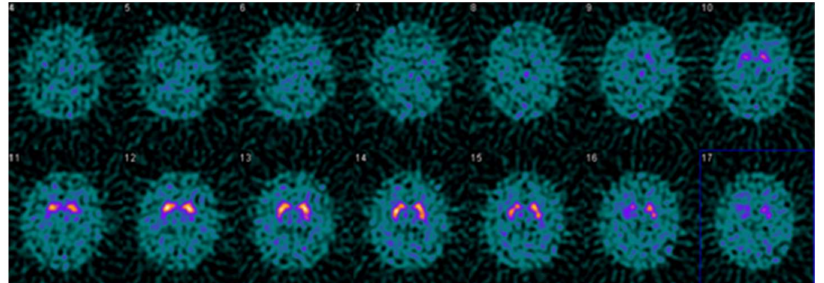
Figure 5. Example DaTQUANT results in a non-PS patient demonstrating visually normal appearing striatum bilaterally. However, the right posterior putamen z-score is − 2.15, meeting the threshold for a diagnosis of PS. This is an example of false-positive quantification, reinforcing the idea that quantification is a useful tool for interpretation, but should not replace visual evaluation. Interestingly, the SBR (1.27) does not meet the threshold for PS, and the percent deviation ( − 0.35) is right at the threshold value for the optimal model ( ≤−